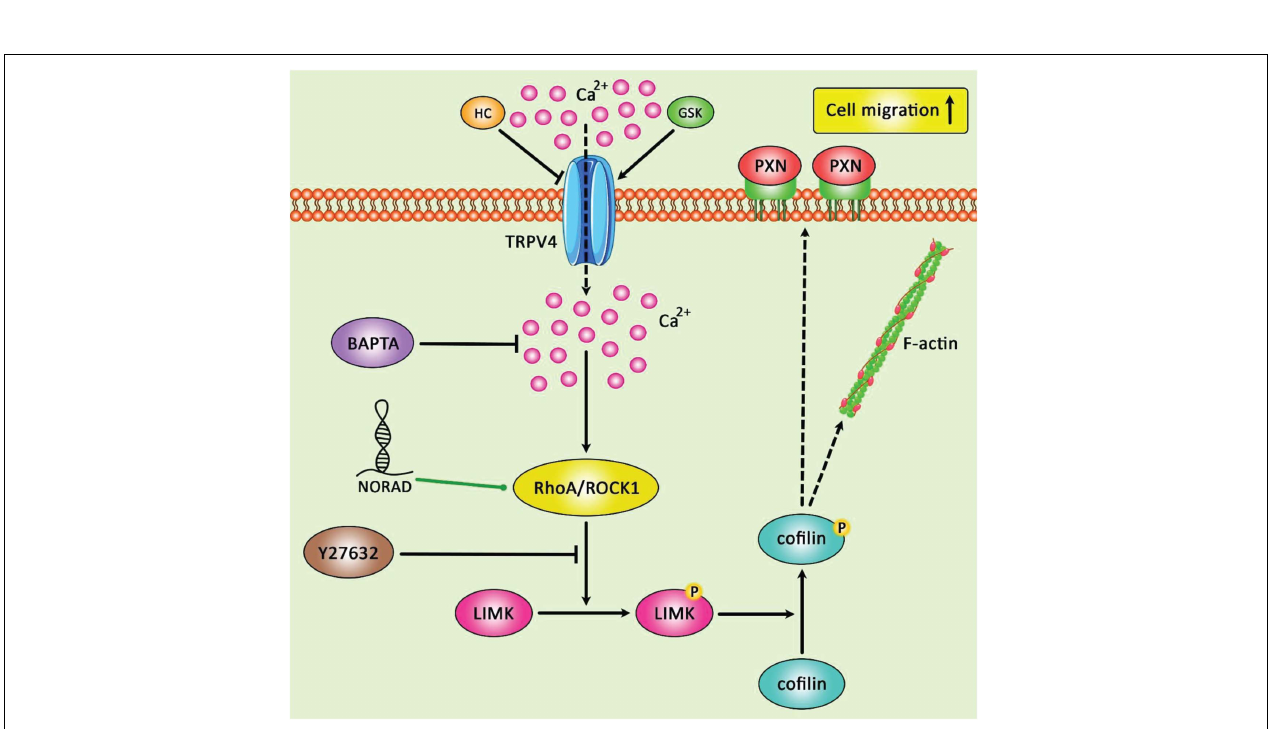
FIGURE 3 | A schematic summary of the crosstalk between the RhoA/ROCK1 singling pathway and lncRNA NORAD in gastric cancer. The figure depicts the impact of RhoA/ROCK1 involved in LIMK/cofilin/TRPV4/Ca2+ pathway in gastric cancer. LncRNA NORAD could promote the expression levels of RhoA and ROCK1, and thereby enhancing cell proliferation, migration and invasiveness and reducing cell apoptosis in gastric cancer cells (Yu et al., 2019).